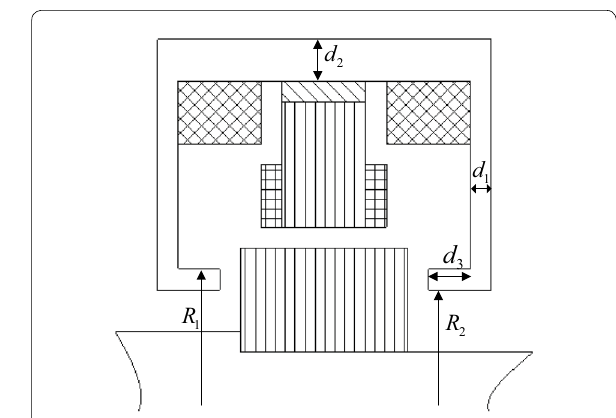
Figure 5 Structure of the axial